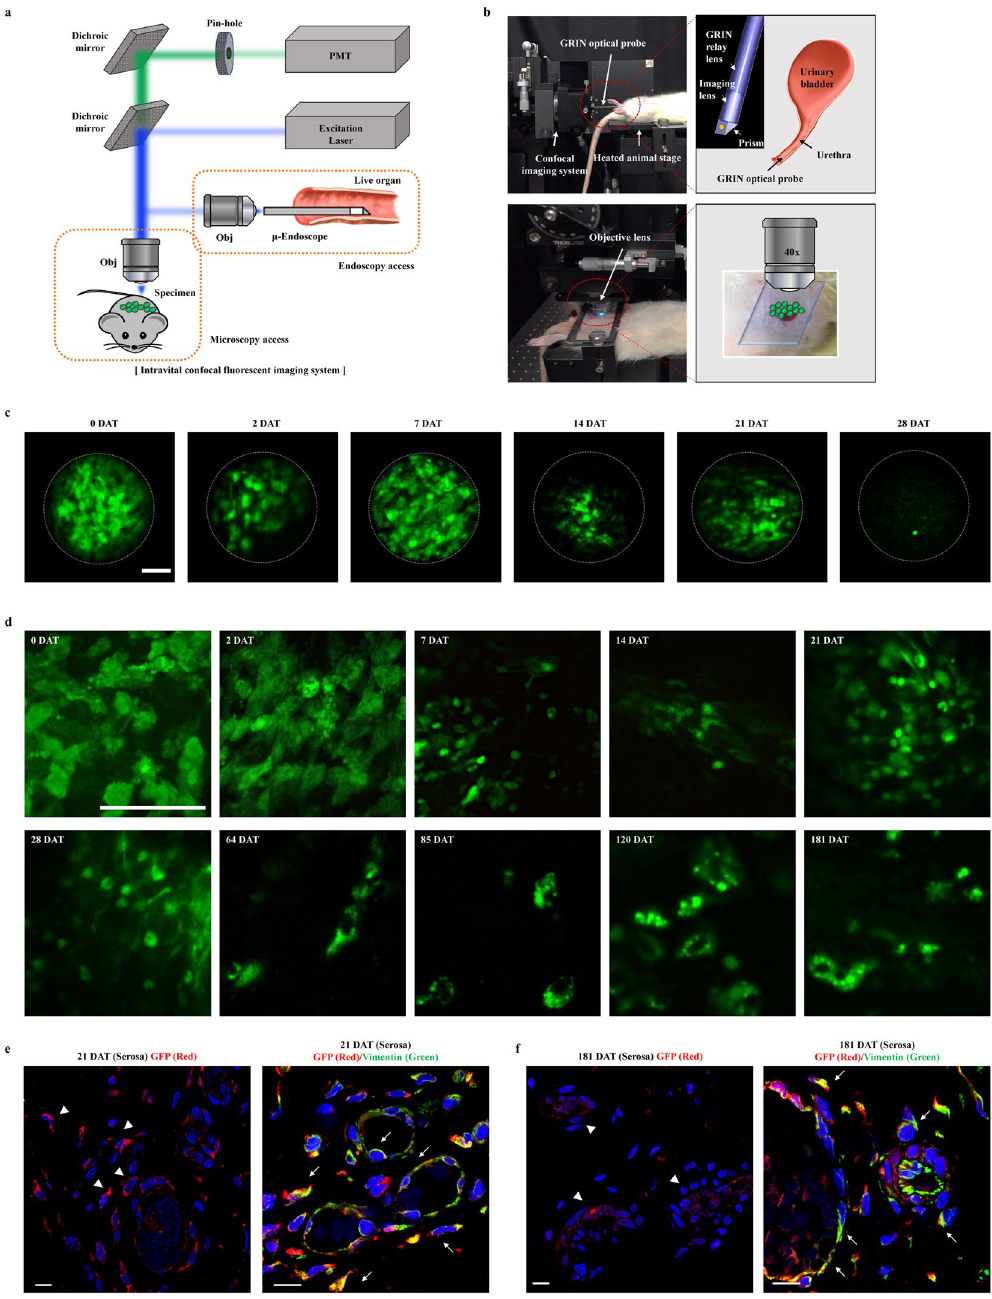
Figure 8. Longitudinal confocal imaging of transplanted M-MSCs in living animals. ( a , b ) Schematic overview ( a ) and working station ( b ) of intravital fluorescence imaging in living animal. Front-view GRIN optical probe is endoscopically inserted into the bladder of an anesthetized rat held on an XYZ stage to access the urothelium surface ( b ; upper panel). Objective lens viewed the outer layer of bladder after making a minimal incision in the overlying abodomen ( b ; lower panel). ( c , d ) Time-lapse imaging (n = 8) of the engrafted M-MSCs obtained by a GRIN optical endoscopic probe ( c , magnification × 40) or objective lens ( d , magnification × 100) in the bladders of HCl-IC rats from 0 day (2 hours) after transplantation (DAT) to 6 months (181 DAT). A majority of transplanted M-MSCs (with GFP fluorescence) were observed in vascular-like structures in the outer layers of the bladder from about 64 DAT. Scale bar = 50 μ m. Representative video-clips acquired by these intravital endoscopes and microscopes are available as Supplementary Movie. ( e ) Representative confocal images for integration of transplanted GFP + cells (red) (magnification × 630) and their differentiation into vimentin + cells near CD31 + vessels (green) (magnification × 1,000). Arrow heads and arrows indicate the engrafted and differentiated cells, respectively. Nuclei were stained with DAPI (blue). Scale bar = 10 μ